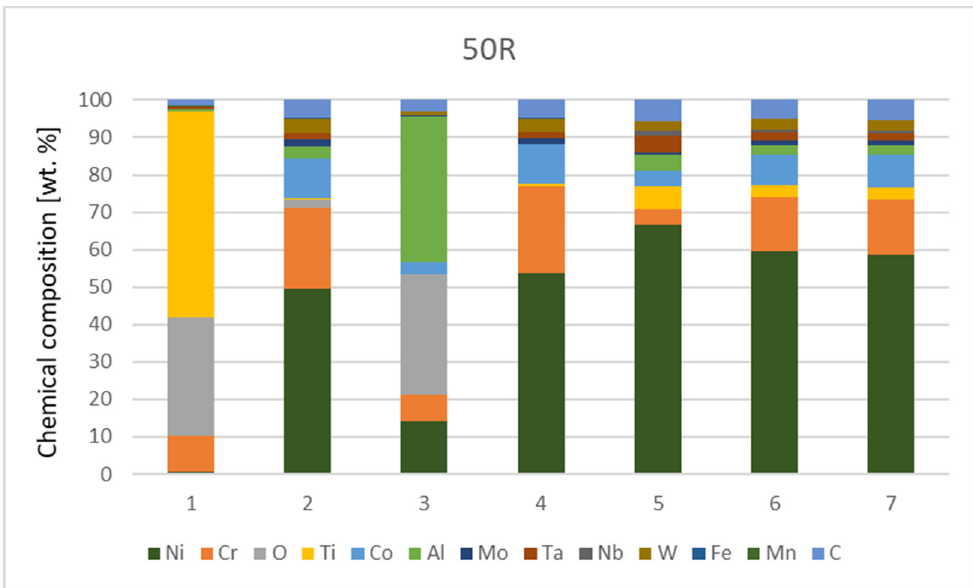
Figure 7. EDX point analysis of IN738 after He exposure, with Inconel phase and oxides on the surface: ( a ) 50R; ( b ) 100R. The chemical composition of point analysis is graphically represented in Diagrams 1, 2. Diagram 1. Chemical composition [wt.%] of IN738—50R after He exposure. Diagram 1. Chemical composition [wt.%] of IN738—50R after He exposure.